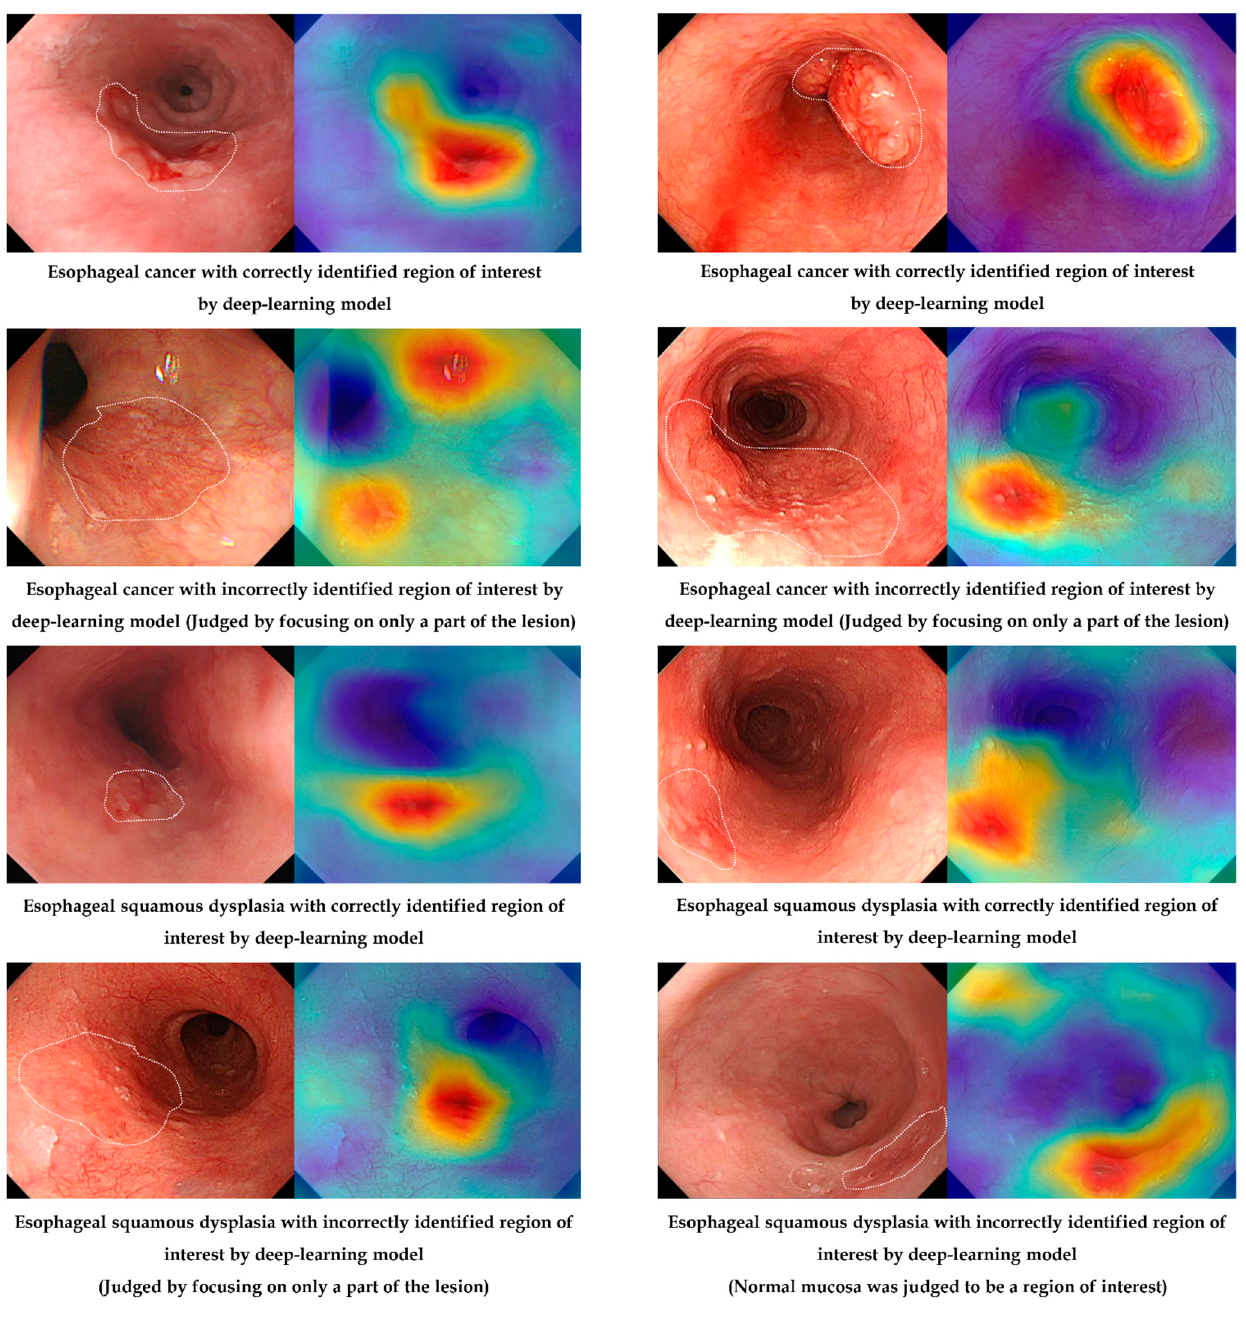
Figure 4. Correctly or incorrectly determined samples in the external test by the established deep- learning